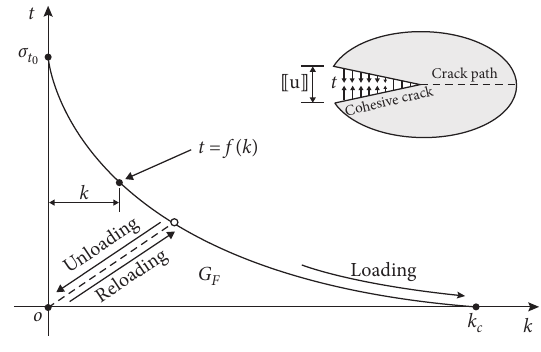
Figure 7: Softening curve for a cohesive crack